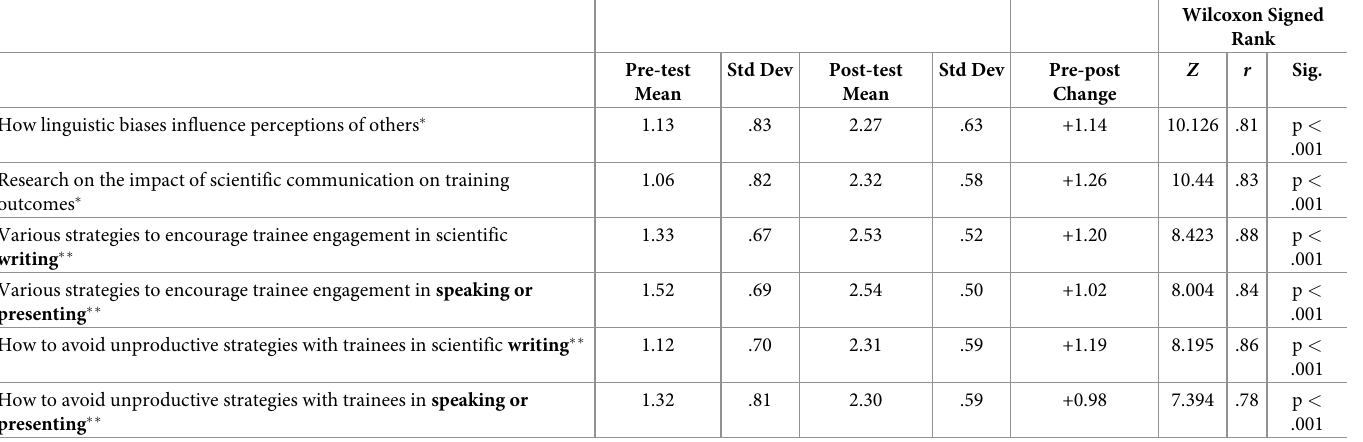
Table 5. Change in participant level of